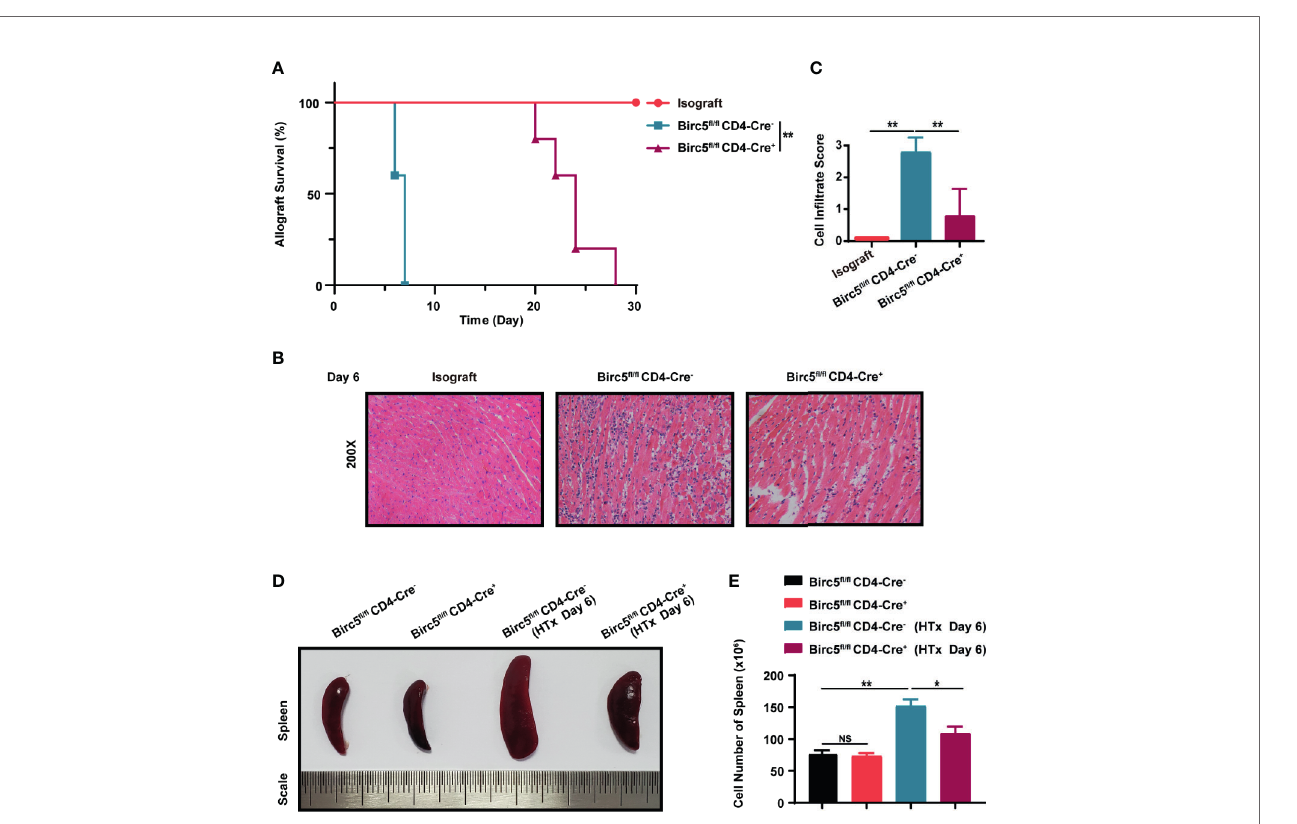
FIGURE 2 | Conditional knockout of Birc5 in T cells alleviates acute allograft rejection after murine heterotopic heart transplantation. (A) Kaplan-Meier survival curves of heart allografts in Isograft, WT and Birc5 -/- recipients. (B) Representative H&E staining results showing in fi ltration of immune cells in grafts in Isograft, WT and Birc5 -/- recipients. (C) Histological analysis of the immune cell in fi ltration score in the heart. (D) Representative appearance of the spleen in the four groups and (E) quanti fi cation of cells in the spleen of each group. Data are representative of 3 independent experiments (n = 5 mice per group). Bars represent the mean ± SD. * p < 0.05, ** p < 0.01, ns, not statistically signi fi cant, log-rank (Mantel-Cox) test (A) , Wilcoxon ’ s and Student ’ s t test (2